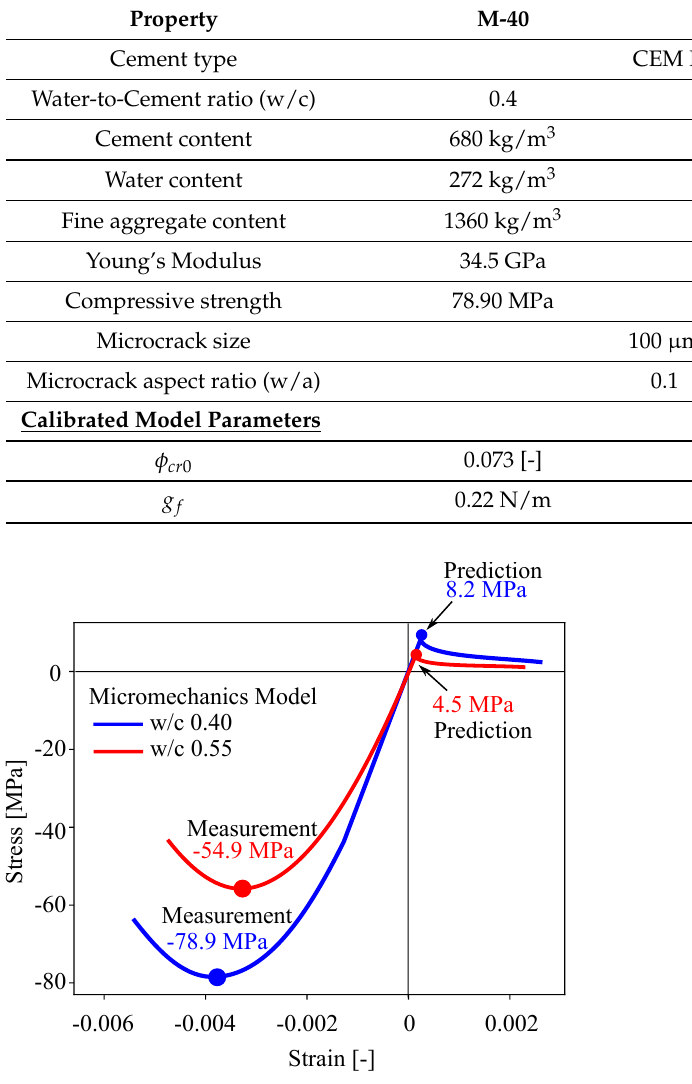
Figure 2. Micromechanics model calibration using data from compressive strength measurements for two different concrete compositions: w/c = 0.40 and w/c = 0.55. Also shown is the predicted tensile